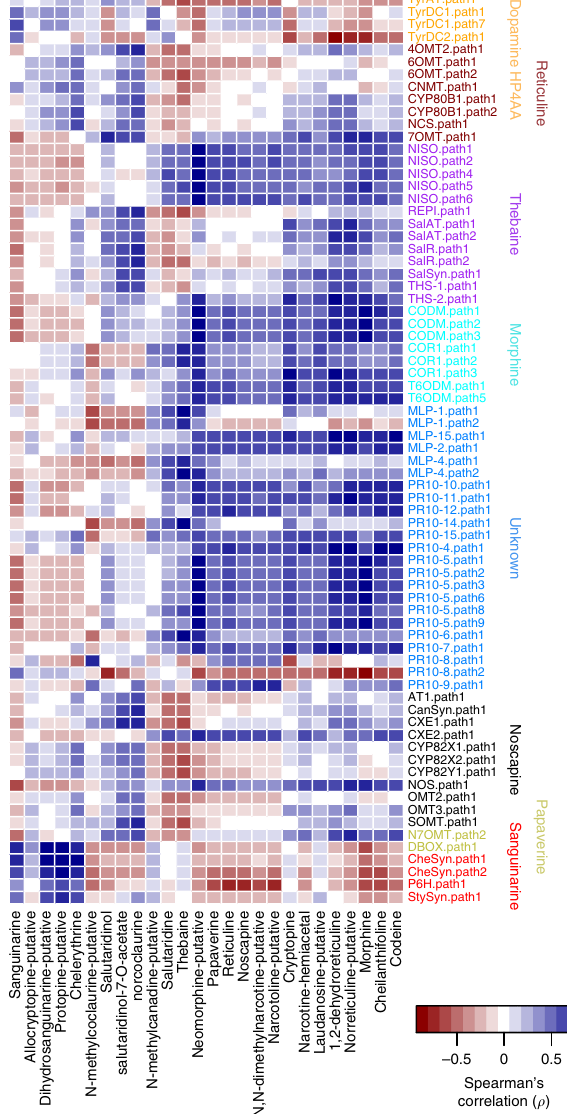
Fig. 4 Covariation between gene expression and alkaloid concentration across tissues and timepoints. Relationships are shown for the main alkaloids of interest and all pathway genes with detectable expression (>0.1 TPM) in at least fi ve libraries. Colors for pathway genes correspond to the coloring in Fig. 2. Source data are provided as a Source Data fi